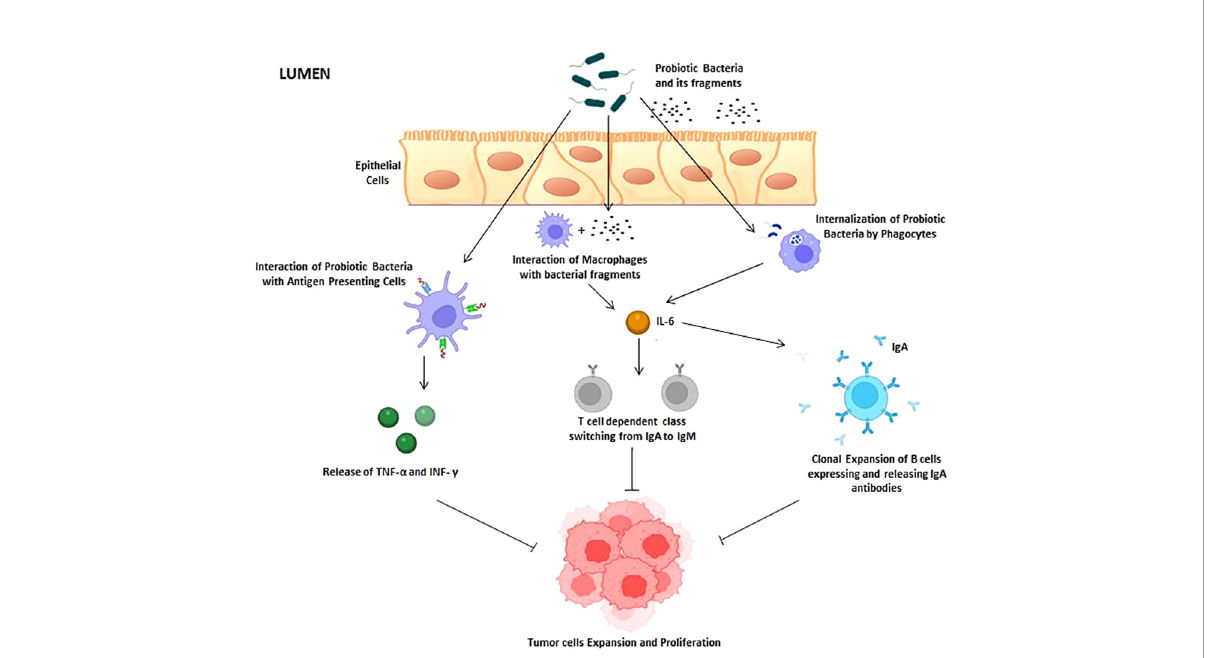
FIGURE 1 Interaction of probiotic cells with host immune system. Probiotic bacteria and its fragments are known to activate antigen-presenting cells (APC), macrophages (MQ), and phagocytes (PC). Once activated, these immune cells produce cytokines and interferon that result in inhibition of tumor expansion and